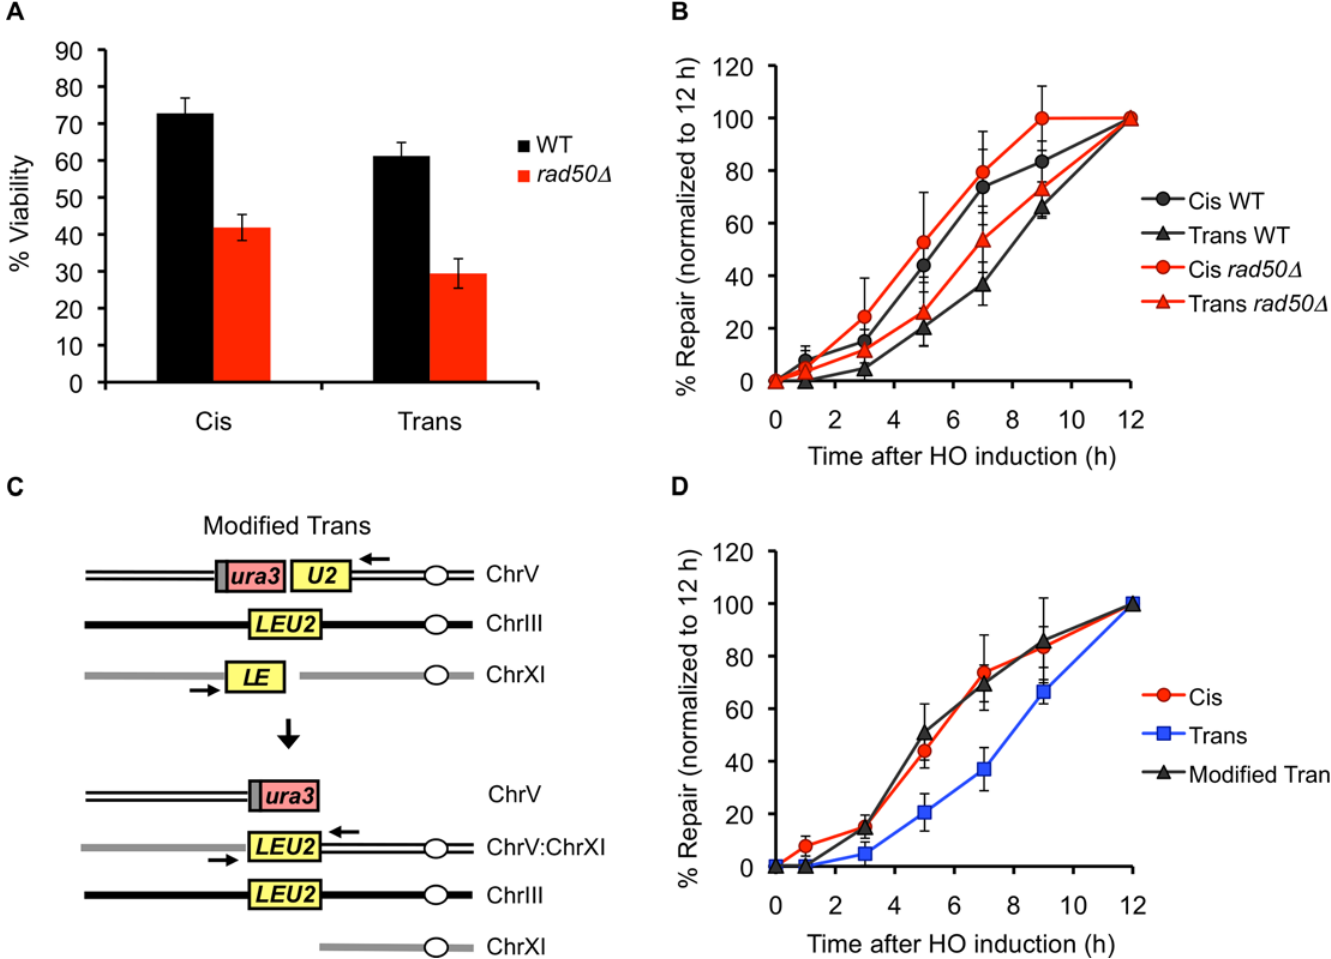
Fig 4. Eliminating the SSA substrate accelerates the kinetics of GC repair in Trans. (A) Viabilities of WT (black bars) and rad50 Δ (red bars) Cis and Trans strains. Data represent mean ± S.D. (n (cid:1) 5). (B) Kinetics of LEU2 repair in the indicated WT (black curves) and rad50 Δ (red curves) strains, as determined by a quantitative PCR assay using primers shown schematically (black arrows) in Fig 1(A) and 1(B). The amount of PCR product obtained from a repaired colony was used to make the standard curve for quantification, and the data was plotted after normalizing the amount of product obtained at the 12 h time point to 100% in each case. For the repair kinetics in the WT background, data represent mean of a total of 6 PCR reactions from two independent time courses ± S.D. For the repair kinetics in the rad50 Δ background, data represent mean of three independent time courses ± S.D. (C) Schematic representation of a modified Trans strain, tNS2628, which carries a 5 ’ truncated ura3-HOcs-U2 cassette at the can1 locus on Chr V, a LEU2 donor on Chr III and an unrepairable LE-HOcs break (instead of an LE-HOcs-URA3 cassette) on Chr XI. Bottom panel indicates the repair outcome in which the LE end from the break on Chr XI and the U2 end from the break on Chr V are repaired by GC using the LEU2 donor on Chr III. However, the other two ends of these breaks cannot be repaired due to the lack of a URA3 substrate on the Chr XI. (D) Kinetics of LEU2 repair in the indicated strains as determined by a quantitative PCR assay using primers shown schematically (black arrows) in Figs 1(A) and 1(B) and 4(C). The amount of PCR product obtained from a repaired colony was used to generate a standard curve for quantification, and the data was plotted after normalizing the amount of product obtained at the 12 h time point to 100% in each case. For Cis and Trans, data represent mean of a total of 6 PCR reactions from two independent time courses ± S.D. For the Modified Trans, data represent mean of three independent time courses ±